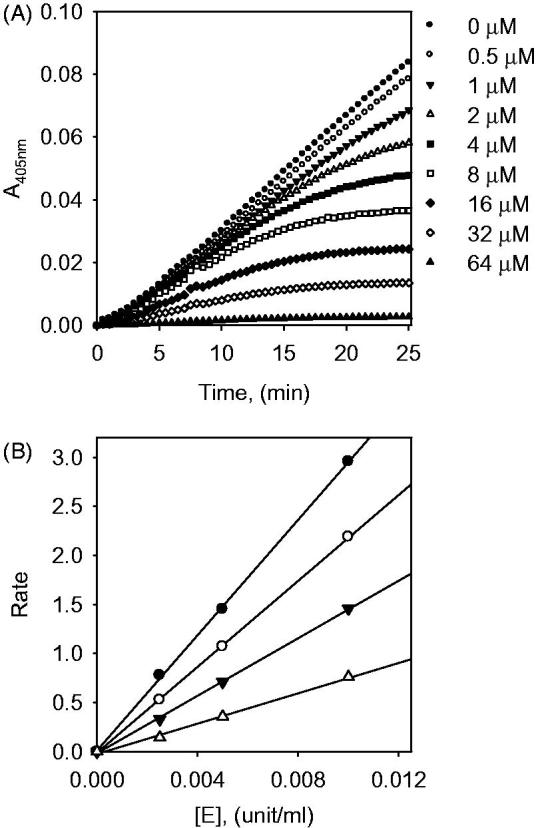
(A) Dose-dependent effect of compound 1 on α-glucosidase inhibition. (B)
The catalytic activity of α-glucosidase as a function of enzyme concentration at
different concentrations of compound 1.